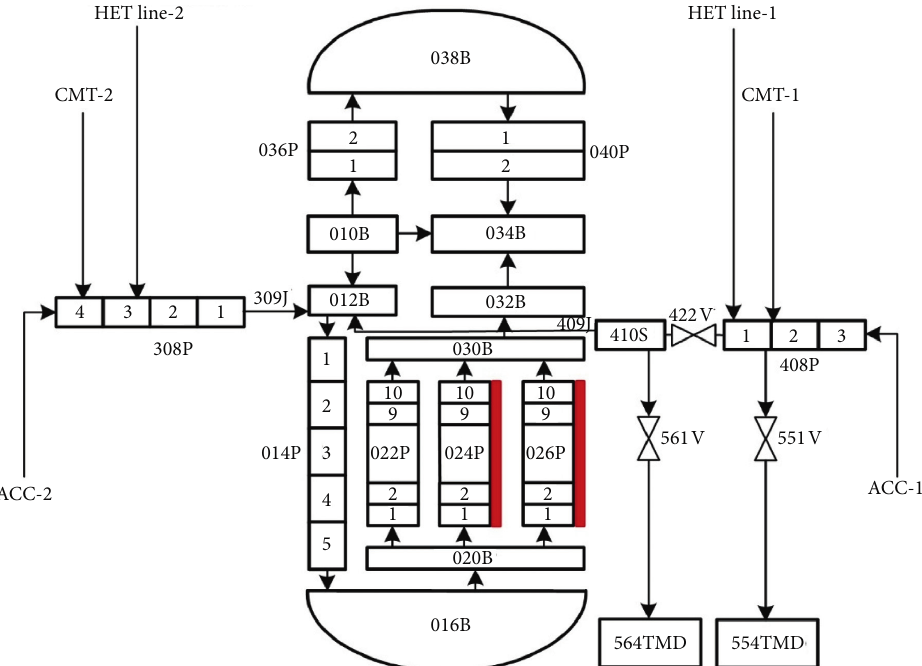
Figure 4: DEDVI line break position.